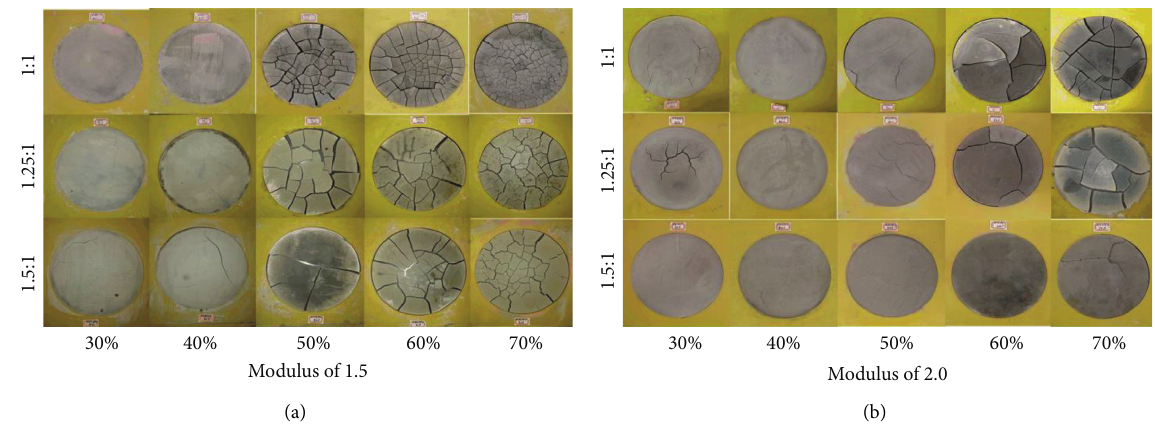
Figure 6: Shrinkage morphologies of geopolymer blocks with different sodium silicates.